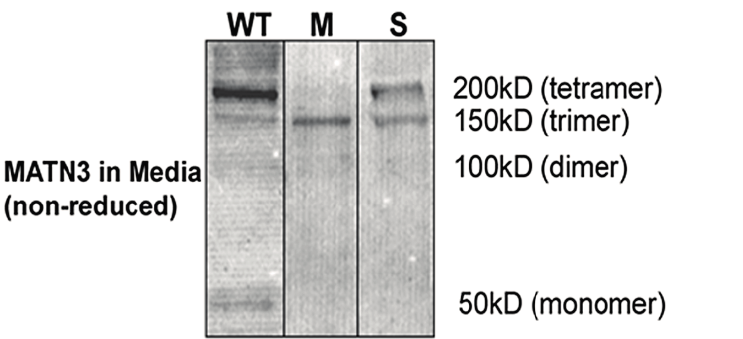
Figure 2. Wild-type (WT) and mutant MATN3 protein production by stably transfected ATDC5 cell lines. Western blot analysis using an anti-V5 antibody to detect recombinant MATN3 protein in media of stably transfected with WT, MED or the SEMD MATN3